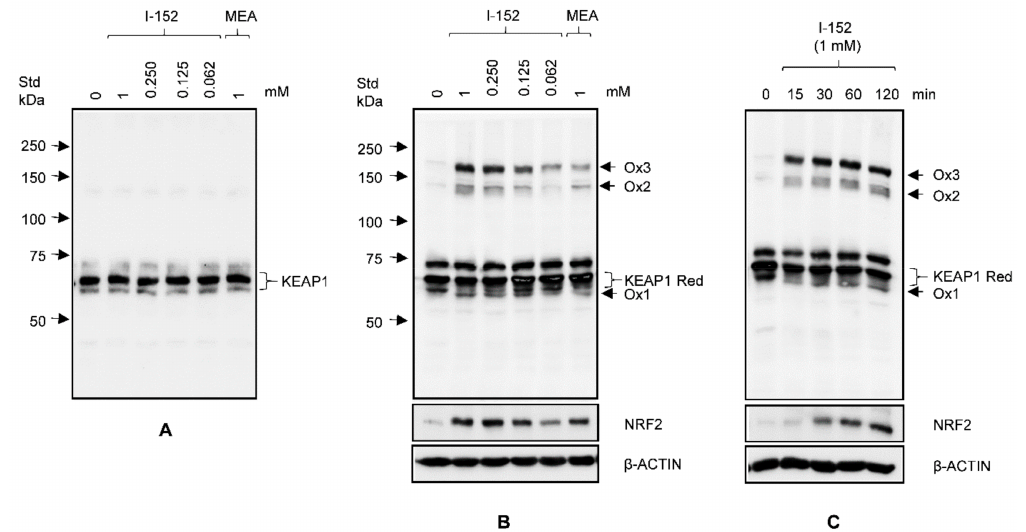
Figure 4. KEAP1 oxidation in cells treated with I-152 and MEA. RAW 264.7 cells were exposed to different concentrations of I-152 and to 1 mM MEA for 2 h. The cells were then lysed in the presence of NEM to block free sulfhydryl groups. The lysates were separated by reducing ( A ) and non-reducing ( B ) SDS-PAGE, and KEAP1 was revealed by western immunoblotting analysis using an anti-KEAP1 antibody. Ten µ g of total proteins were loaded on 8% ( w/v ) polyacrylamide gel. ( C ) Raw 264.7 cells were treated with 1 mM I-152 for different times and lysates, obtained as in A, were separated under non-reducing conditions. In panels B and C, the blots were re-probed with anti NRF2 antibody and β -ACTIN was stained as a control. Arrows on the right side indicate the oxidized faster migrating (Ox1) and the oxidized slower migrating (Ox2 and Ox3) KEAP1 species, while brackets show the position of reduced (Red)